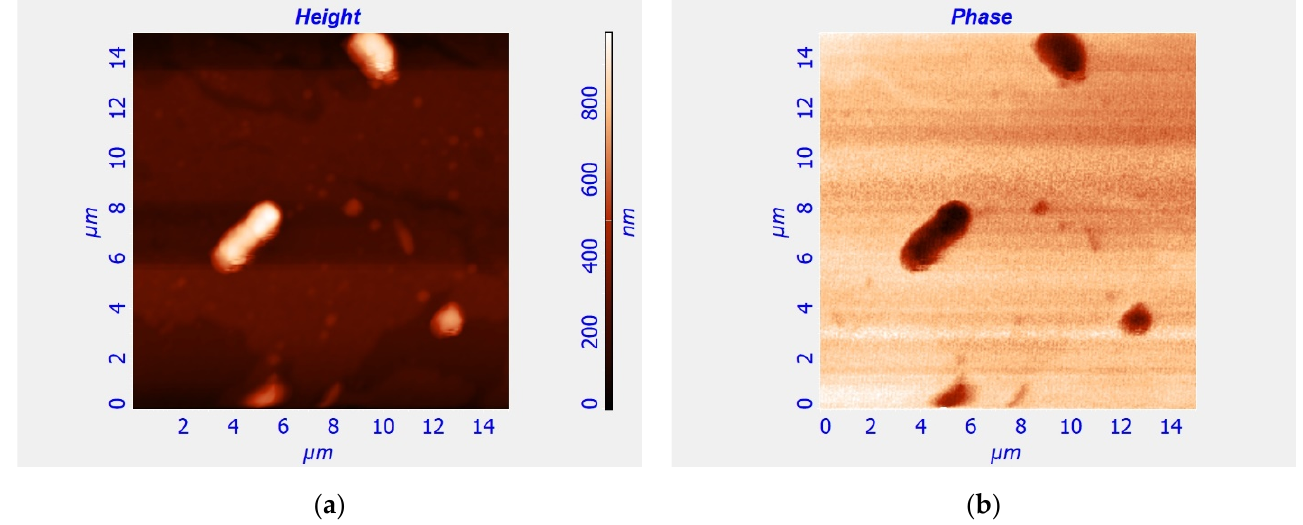
Figure 5. AFM ( a ) and MFM ( b ) images of EcN cells cultivated on standard medium (control). The left image represents AFM of EcN cells, i.e., topography of the surface of EcN cells at the cover glass. The color bar for left image shows the height in nanometers illustrating the shape and size of EcN cells. The right image represents MFM (of the same EcN cells as in left image) in the dynamic MFM mode. The abrupt change of color between inside and outside regions of EcN cells in the right image means that the force of magnetic interaction of the magnetic tip of the cantilever with the EcN cells differs in a step-like manner from the force of interaction with the diamagnetic cover glass.